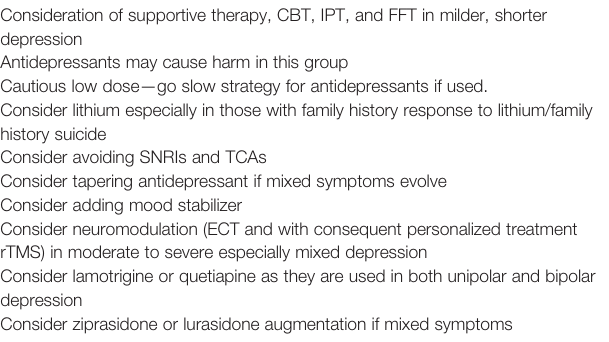
TABLE 4 | Treatment considerations for major depression with family history of bipolar disorder or suicide. Consideration of supportive therapy, CBT, IPT, and FFT in milder, shorter depression Antidepressants may cause harm in this group Cautious low dose — go slow strategy for antidepressants if used. Consider lithium especially in those with family history response to lithium/family history suicide Consider avoiding SNRIs and TCAs Consider tapering antidepressant if mixed symptoms